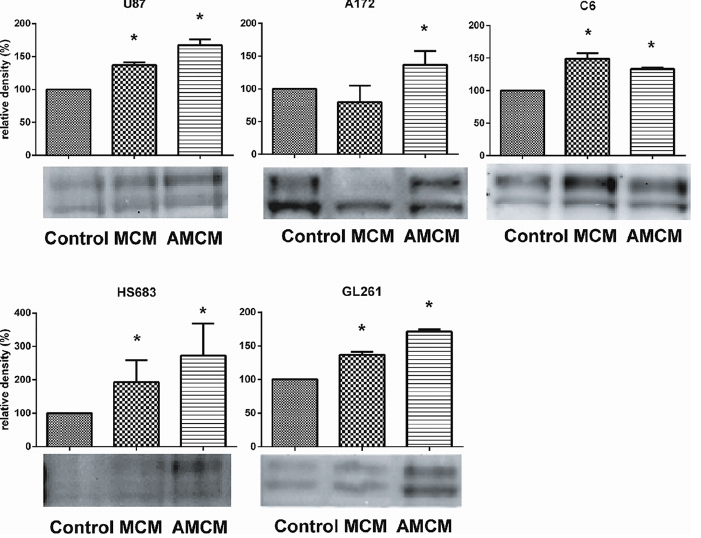
Fig 3. Factors released from microglia upregulate phosphorylation of Pyk2 in glioma cells. Western blot analysis of pPyk2 (Tyr 579/580) protein in glioma cell lines. The signal is detected at the area corresponding to molecular weight of 116 kDa. The graph shows the density of protein in MCM and AMCM treatments relative to control. Two bands in pPyk2 (Tyr 579/580) detection identify phosphorylation in one or both sites. Intensity of the chemiluminescence signal was corrected for minor changes in protein content after densitometry analysis of the India ink stained membrane. The India Ink stained membranes are provided in S1 Fig. The “ relative density ” axis for HS683 cells is shown in a higher grid scale compare to other cell lines due to higher relative up regulation of Pyk2 phosphorylation in this cell line. Results are presented as mean ± S.D. with significant differences from control ( * ) (p < 0.05). One-way ANOVA followed by the Tukey ’ s multiple comparison test was used to determine significance between MCM or AMCM groups compared to control. 5 repeated experiments (N = 5) for each cell line were used for statistical